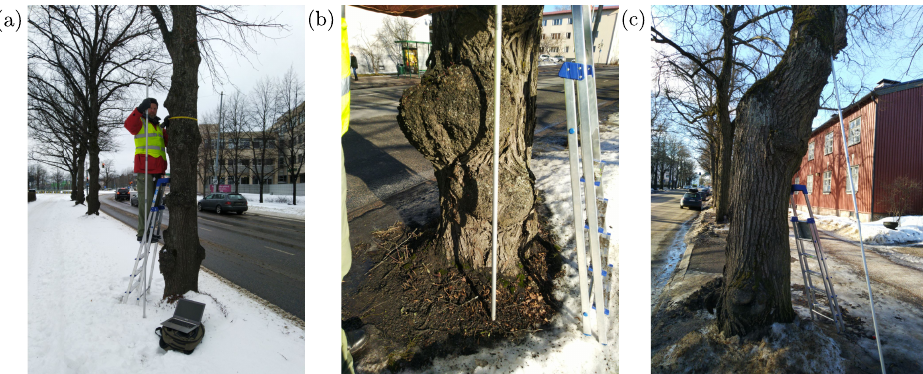
Figure 1. ( a – c ) Photographs of three example roadside trees located in the test